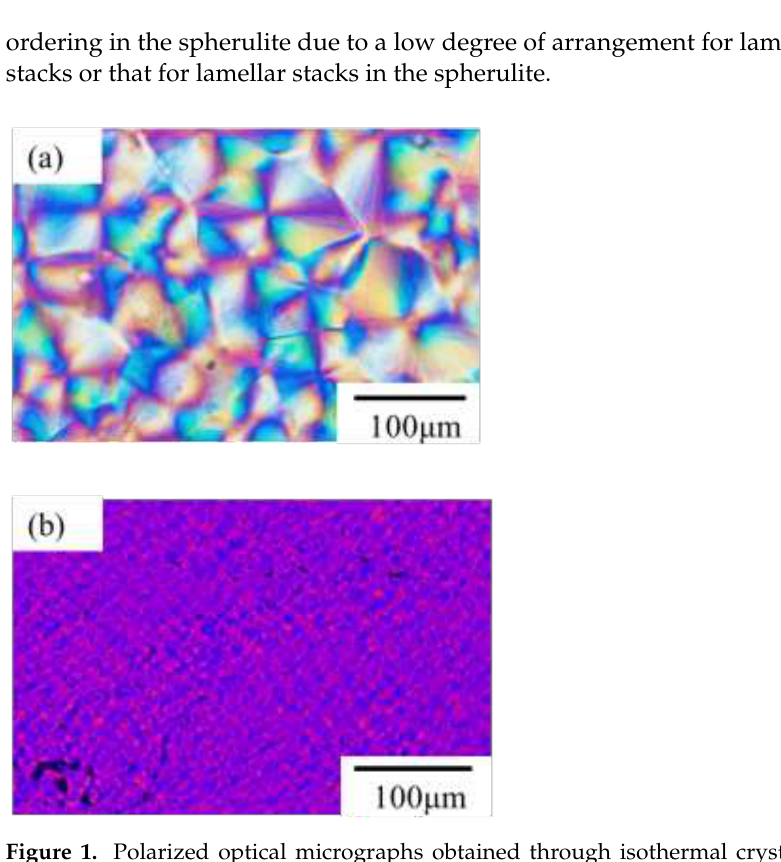
Figure 1. Polarized optical micrographs obtained through isothermal crystallization at 165 °C: ( a ) α -spherulite of neat PVDF; ( b ) γ -spherulite of PVDF/TBAHS.